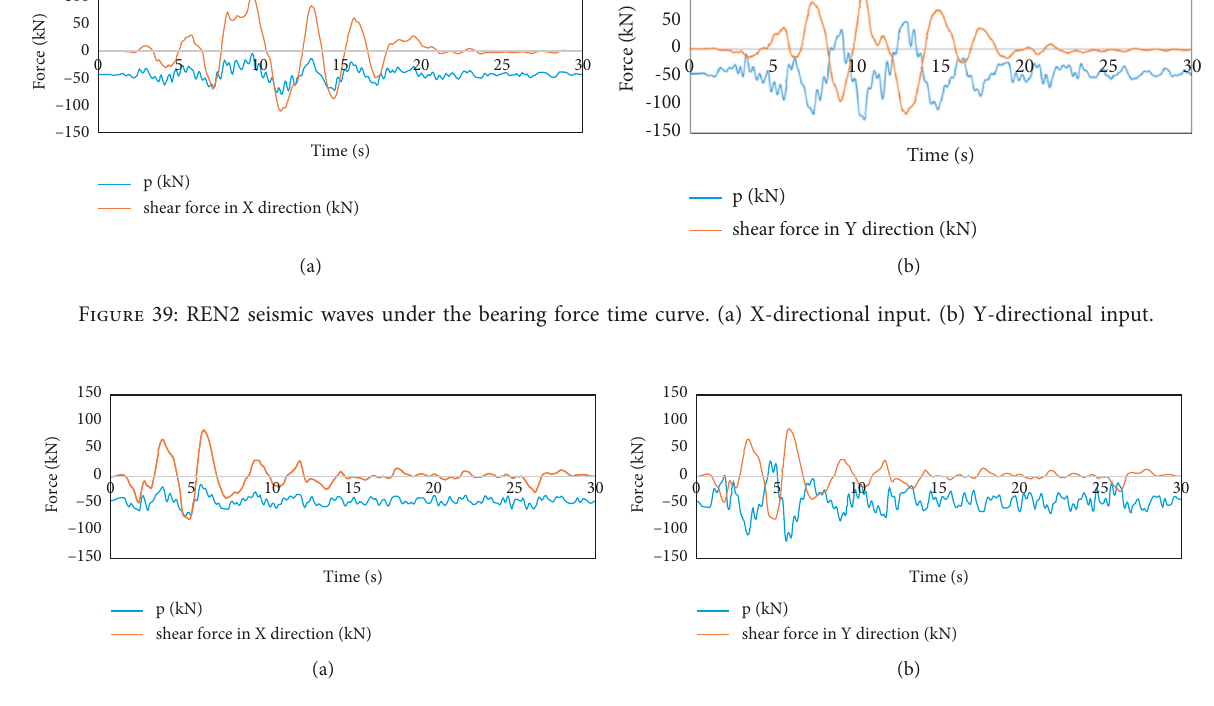
Figure 40: Time course curve of bearing force under ELC seismic wave. (a) X-directional input. (b) Y-directional input.